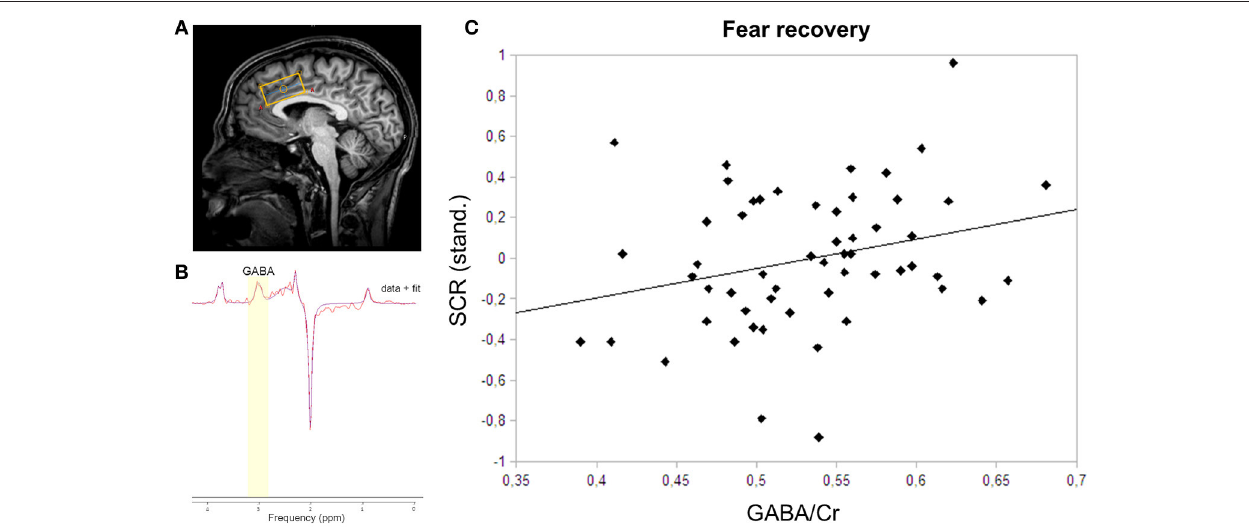
FIGURE 2 | MRS voxel placement, MRS spectrum with fit, and correlation plot of GABA and skin conductance responses. (A) The MRS voxel was planned on the anatomical scan of each participant. The 40 × 20 × 20 mm 3 box was closely aligned with the corpus callosum in the dACC. (B) GABA was fitted onto the spectrum using AMARES in jMRUI. GABA was fitted using a Gaussian function at 3.0 ppm. (C) The correlation of dACC GABA concentrations and skin conductance responses to the CS + relative to the CS − during fear recovery revealed a positive relation ( r s = 0.28; P = 0.04).